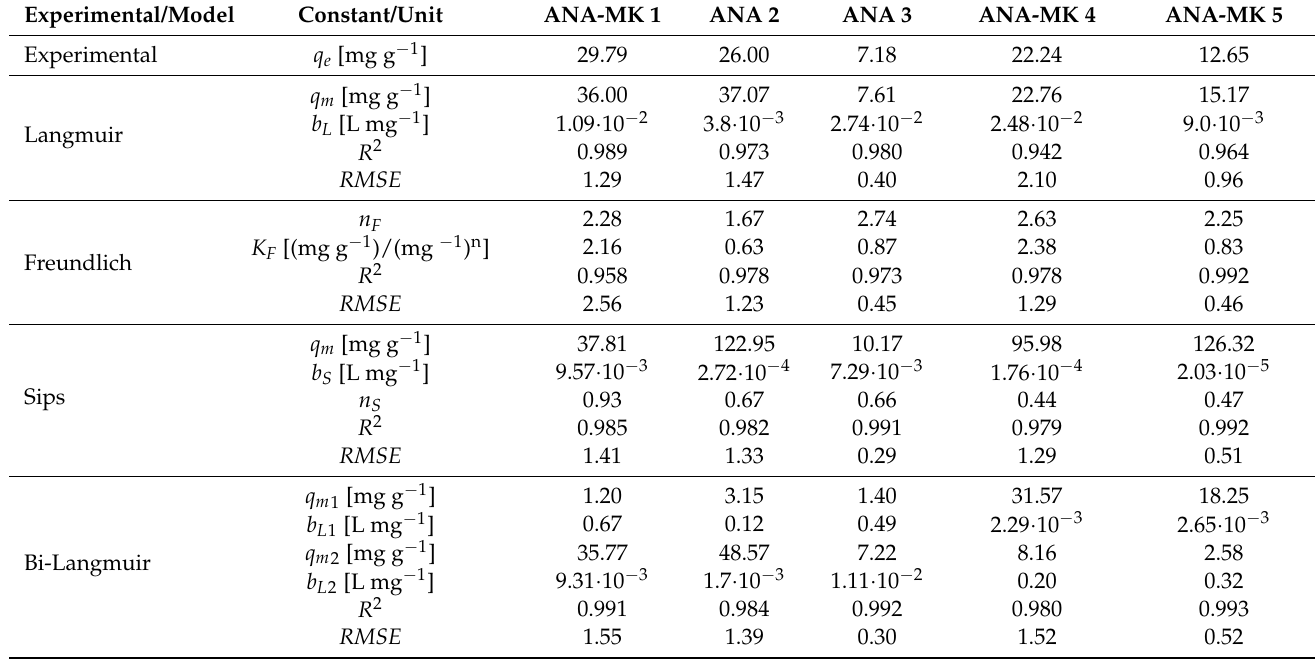
Table 6. Parameters for the sorption